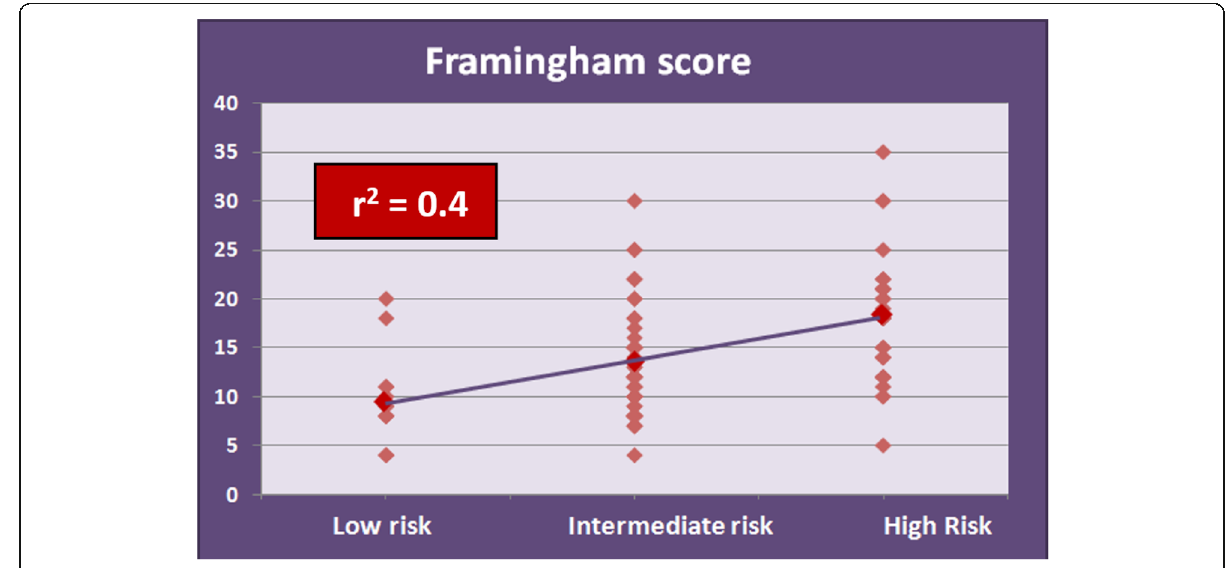
Fig. 1 GWR correlation with Framingham ’ s